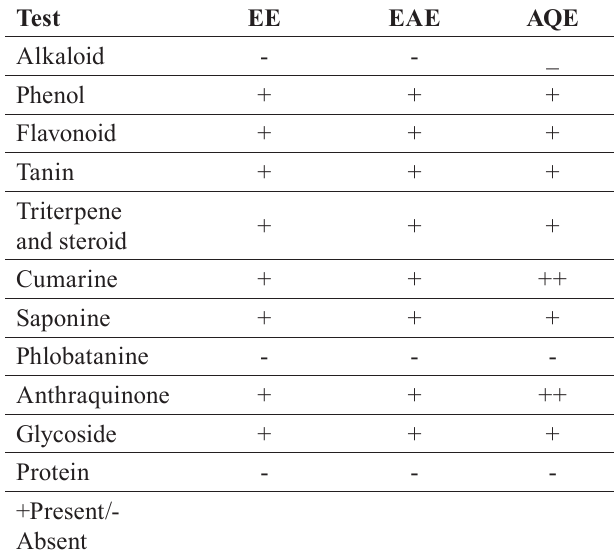
TABLE II - Qualitative phytochemical constituents of different seed